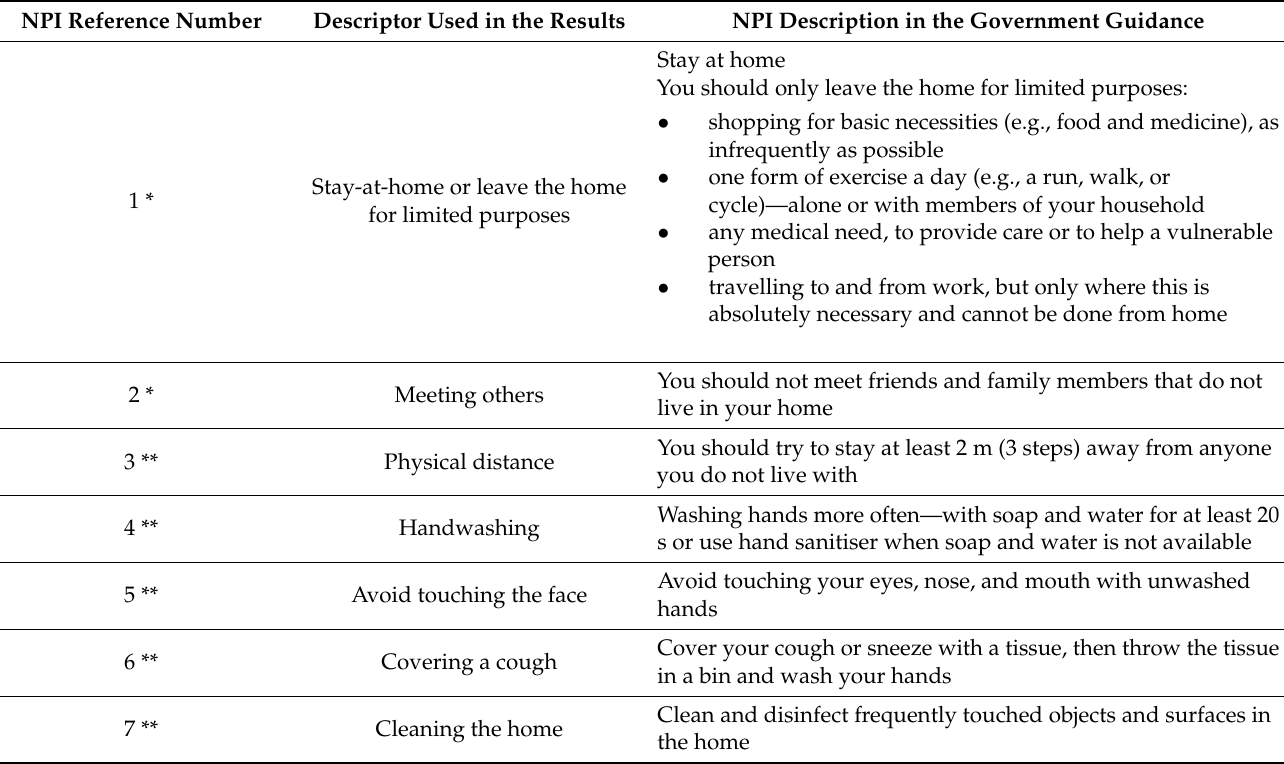
Table 1. Non-pharmaceutical interventions (NPIs)